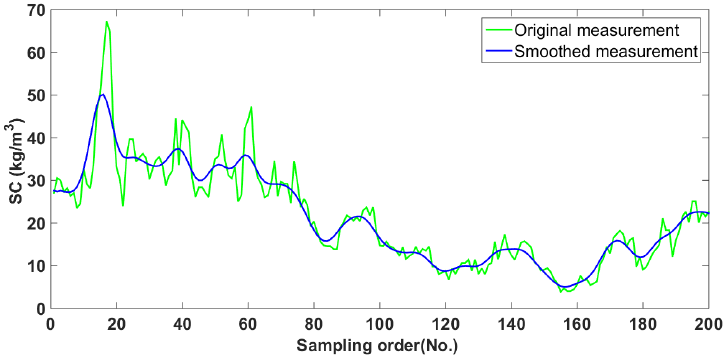
Figure 3. Smoothed SC measurements.